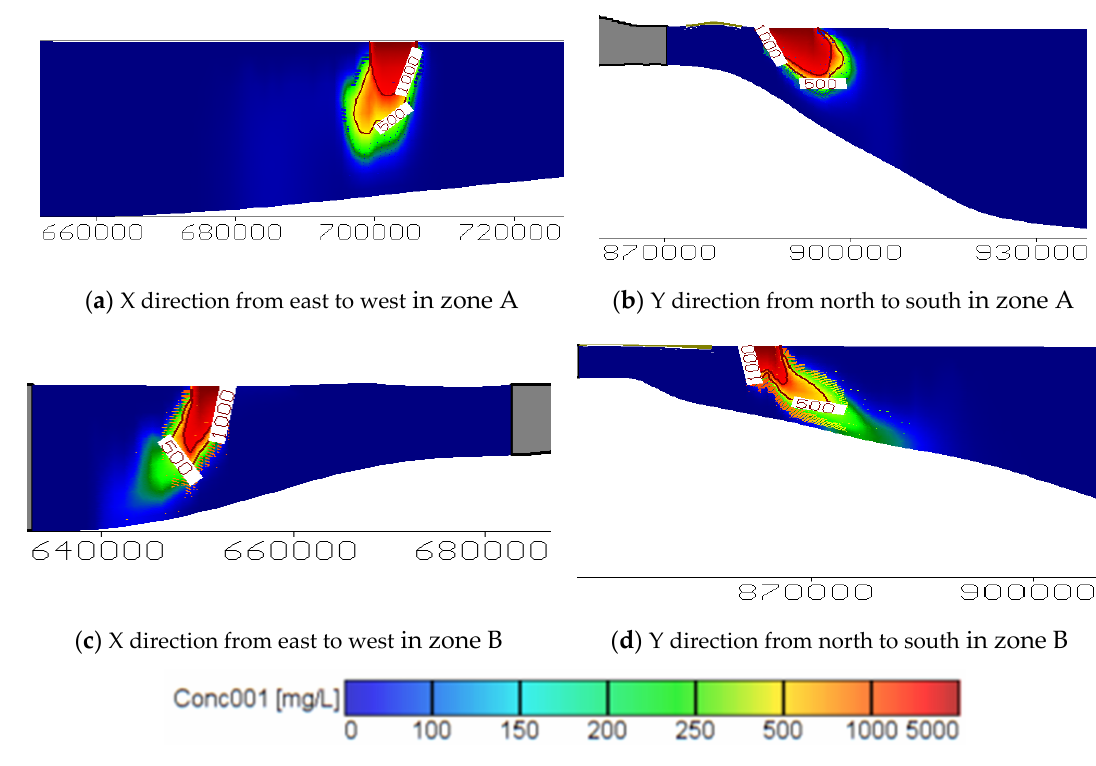
Figure 6. Contaminant extension in the ENDA.